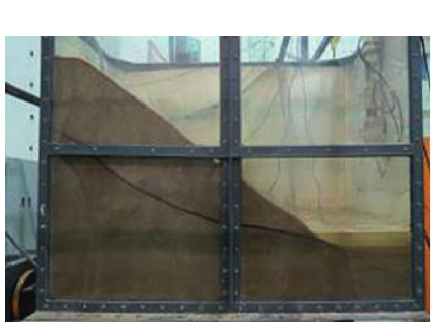
Figure 12: Simulation of slope